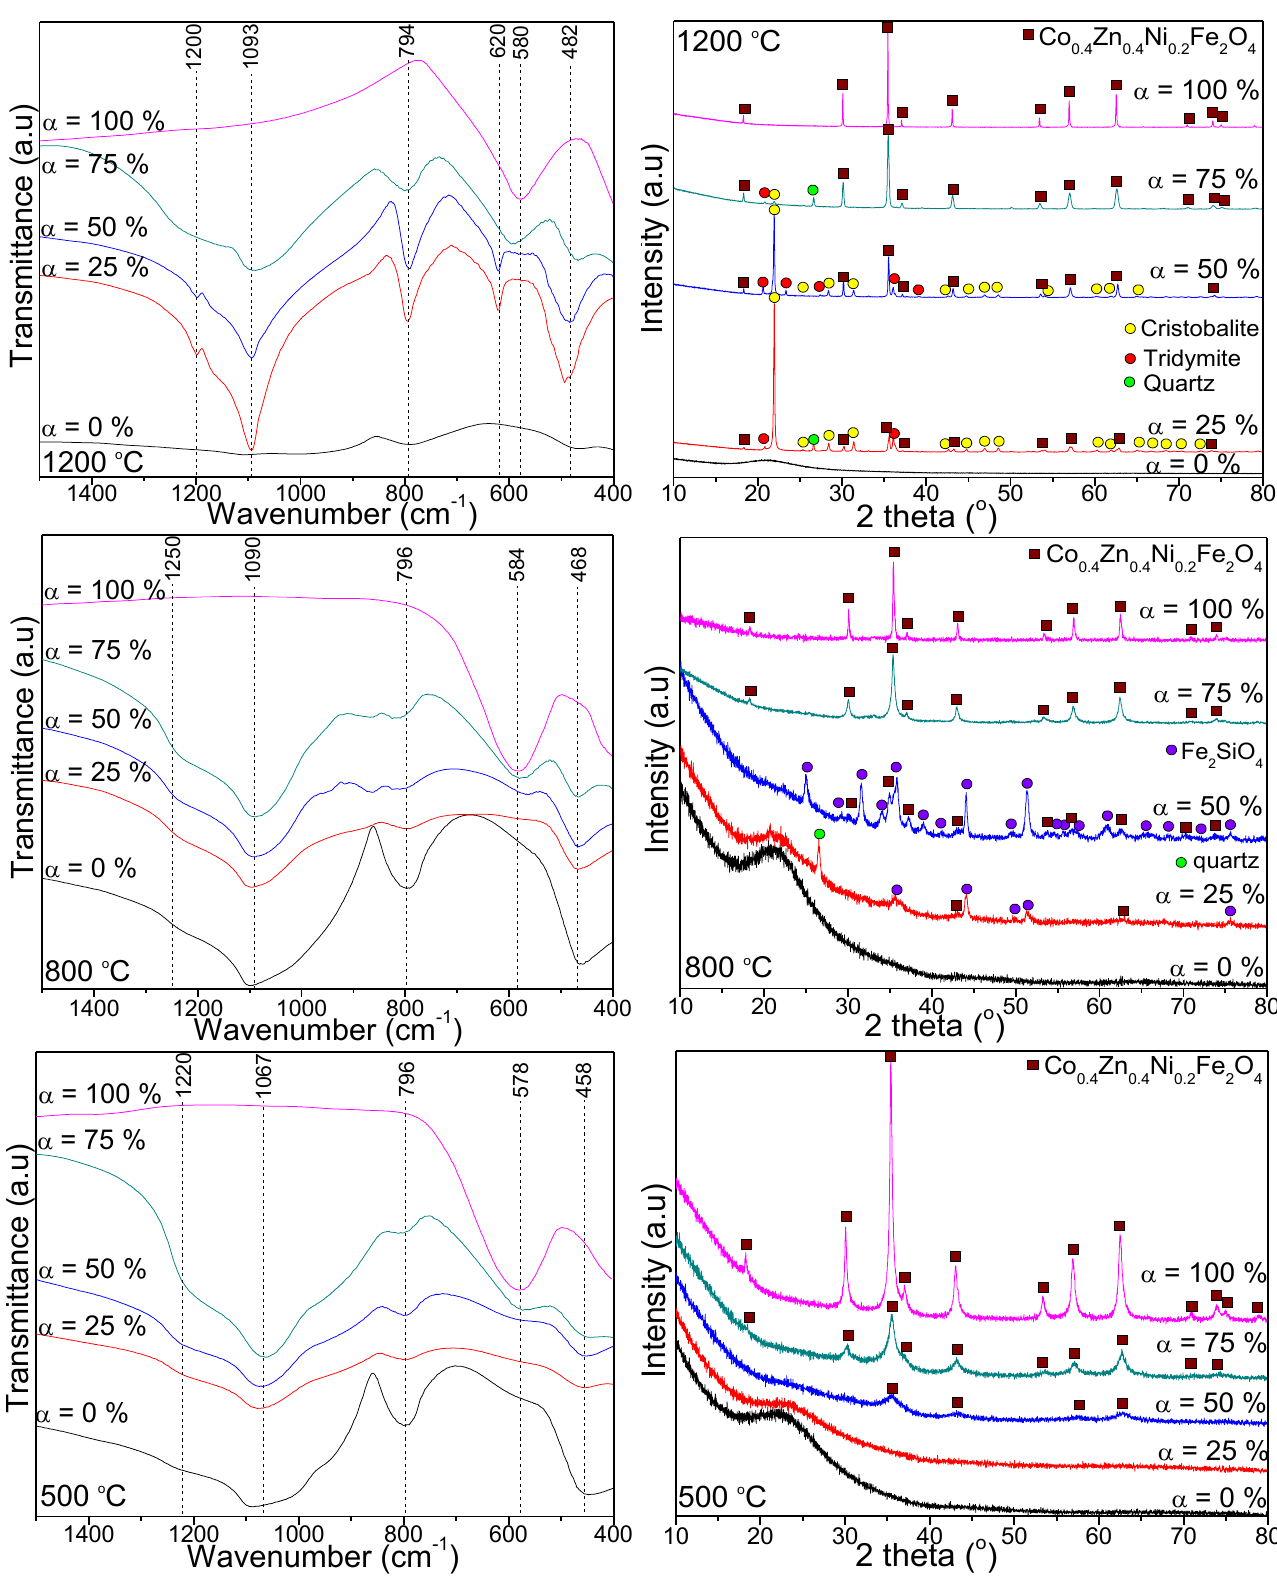
Figure 3. FT-IR spectra (left) and XRD patterns (right) of (Co 0.4 Zn 0.4 Ni 0.2 Fe 2 O 4 ) α (SiO 2 ) 100 − α samples annealed at 500, 800, and 1200 °C.